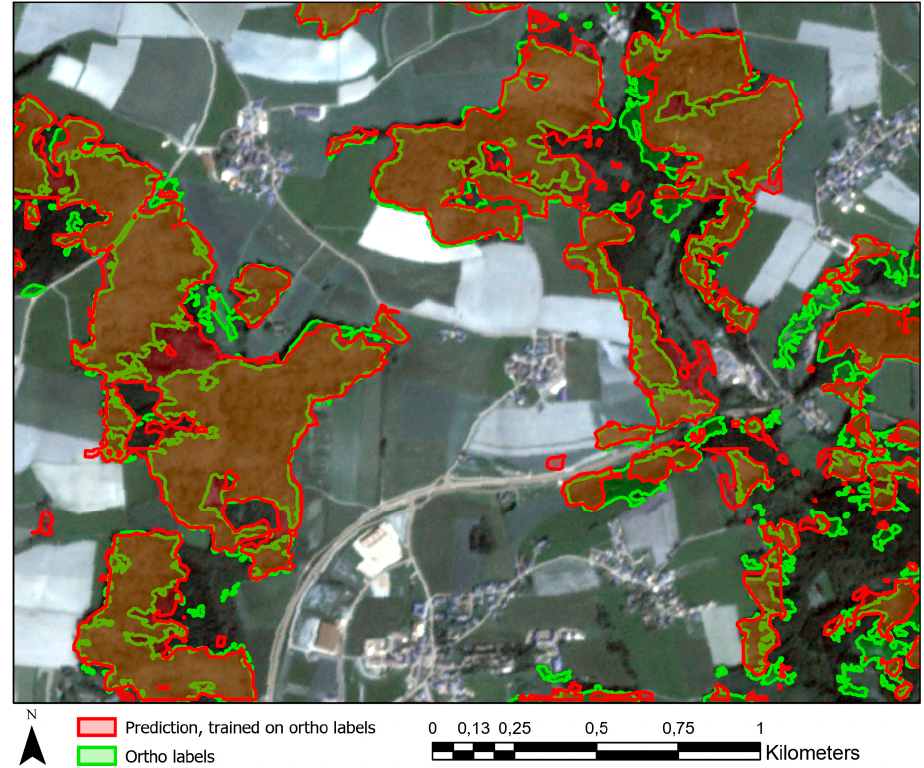
Figure 8. Prediction (red) on PlanetScope satellite image compared to labels (green). Remote Sens. 2020 , 12 , x FOR PEER REVIEW